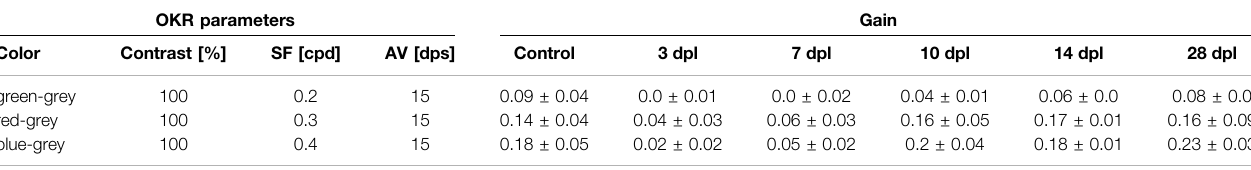
TABLE 2 | Individual data points for the second level of the OKR-based vision test during the course of regeneration. OKR